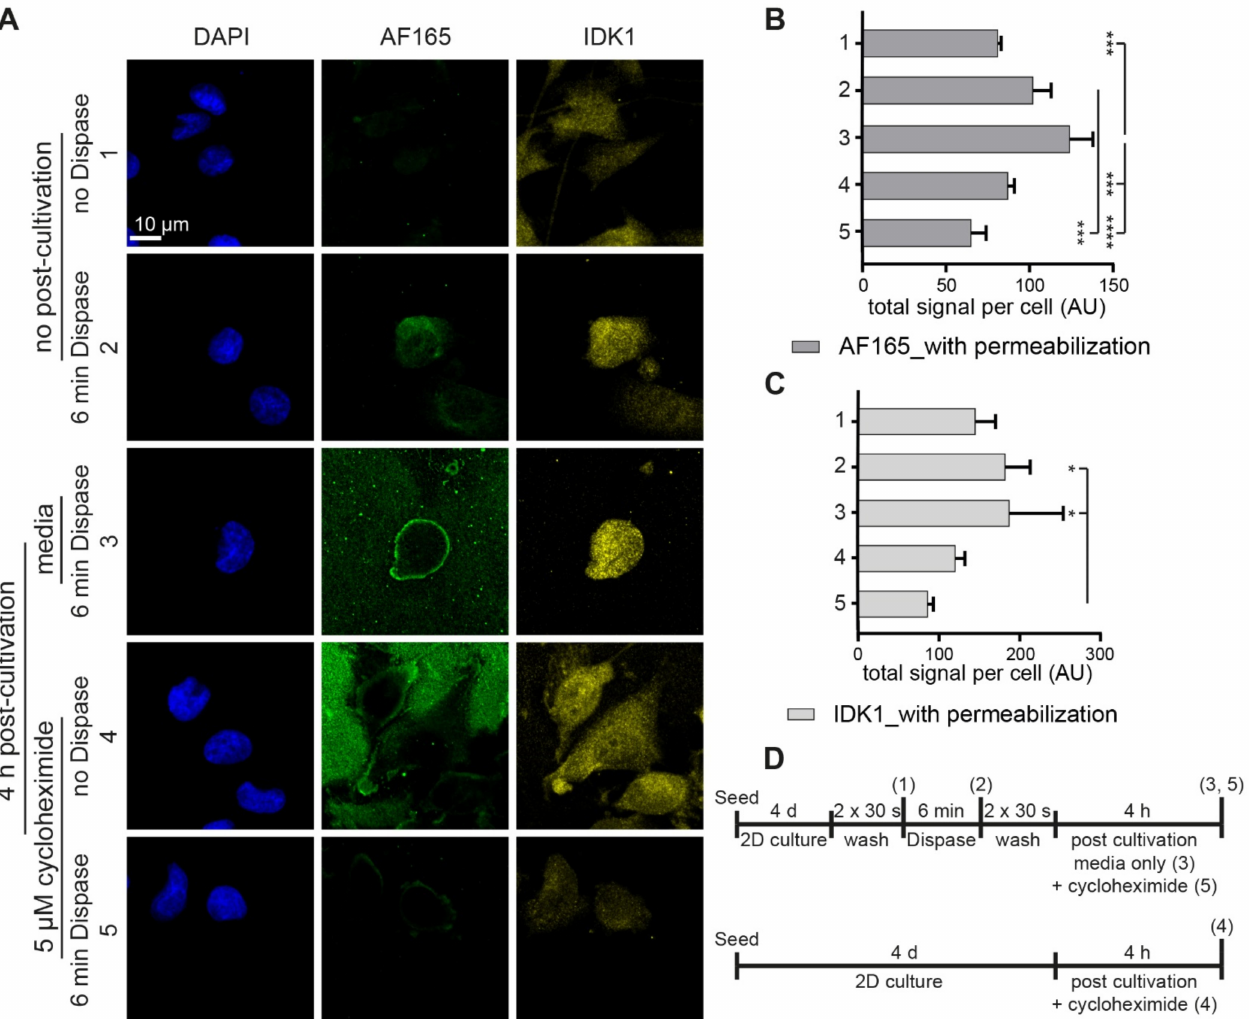
Figure 4. Dispase induces BSP biosynthesis in MDA-MB-231 cells. 1,200,000 MDA-MB-231 cells were seeded in Petri dishes containing glass cover slips. After 4 d, cultures were treated with dispase and partially further cultivated with media or for secondary treatments with cycloheximide after washing as indicated. PFA fixed samples were permeabilized and then stained for DAPI and BSP (AF165 and IDK1). ( A ) Representative confocal images in sum projections. ( B , C ) Graphs showing quantitative analysis of fluorescence intensity per cell. See ( D ) for methodology. Mean + SD ( n = 3; * p < 0.05, *** p < 0.001, **** p <